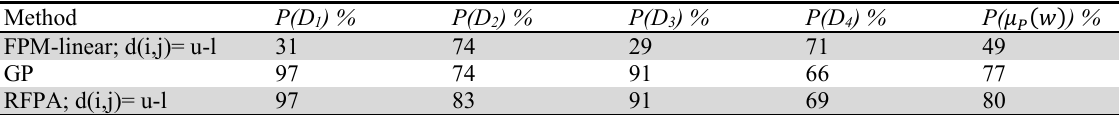
Performance of methods on five indicators